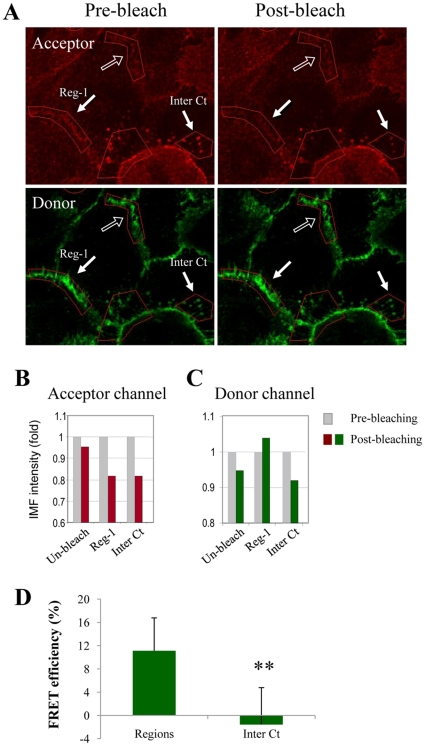
FRET analysis of Dsg3 and E-cadherin association.(A) HaCaT cells were labelled for E-cad with HECD-1 and A488 conjugate and Dsg3 with rabbit Ab and A555 conjugate, respectively. Here arrows designate a peripheral region (Reg-1) with FRET and an intracellular (Inter Ct) region which served as a negative control the open arrow indicates region where no photo-bleaching was performed so that photodamaging was recorded. Bar, 10 µm. (B,C) Numerical quantification of fluorescent intensity in the acceptor and donor channels of the image. (D) Numerical quantification of FRET efficiency (n = 3). ** Statistical significance P<0.01 using Students' T-test.